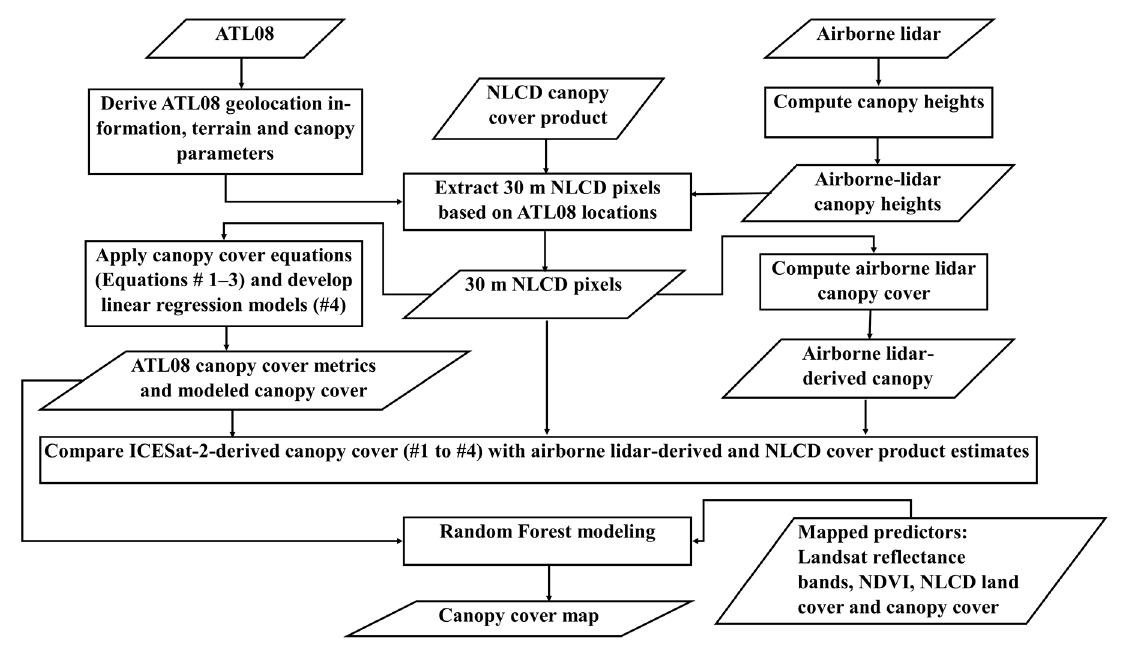
Figure 1. Workflow for mapping canopy cover with ICESat-2. Slanted boxes represent data, straight boxes indicate actions, and arrows denote sequence or flow between data and actions. Table 1. Data used to determine a framework for producing a 30 m canopy cover product with ICESat-2.